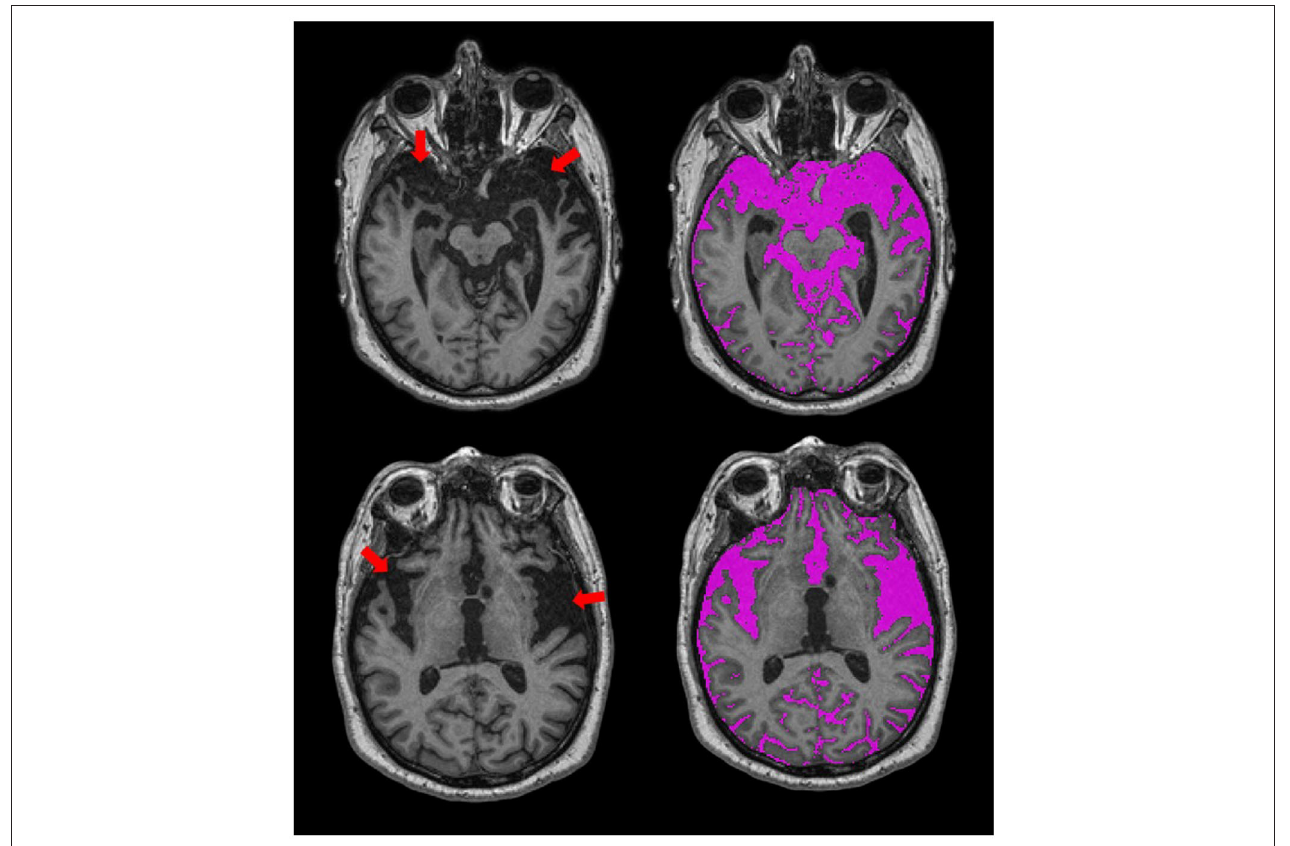
FIGURE 4 | Axial views of T1-weighted MRI from an ONDRI FTD patient. Red arrows point to regions with significant focal brain atrophy. The SABRE-LE processing pipeline accounts for this focal atrophy since it includes a measure of everything below the dura mater, including sub-arachnoid and sulcal cerebrospinal fluid (CSF), shown in